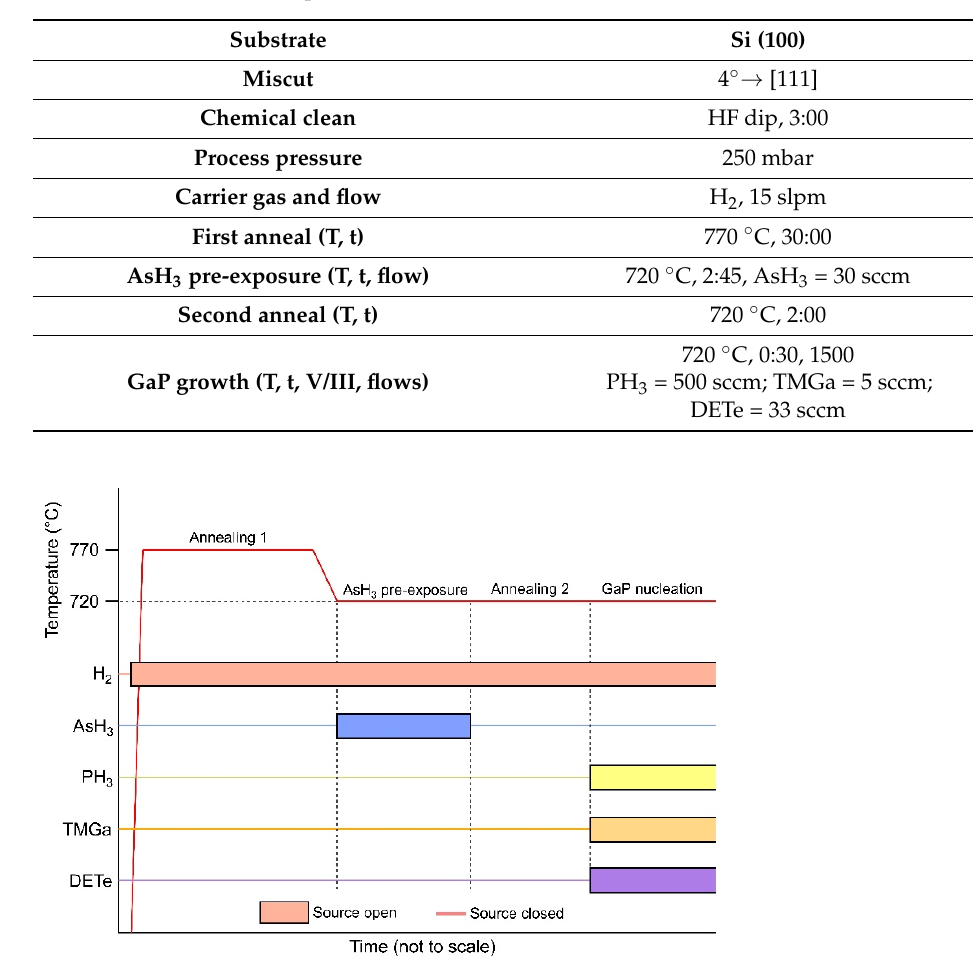
Figure 4. Diagram summarizing the routine developed for the GaP nucleation on